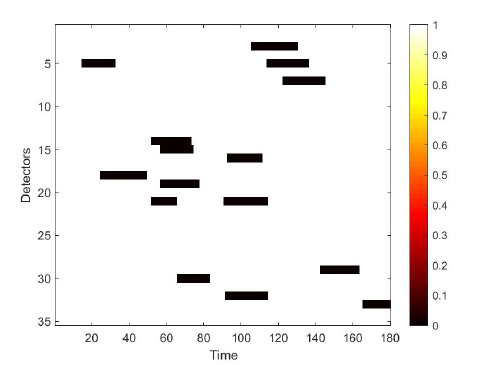
Figure 7. Mask used to simulate strip damage.